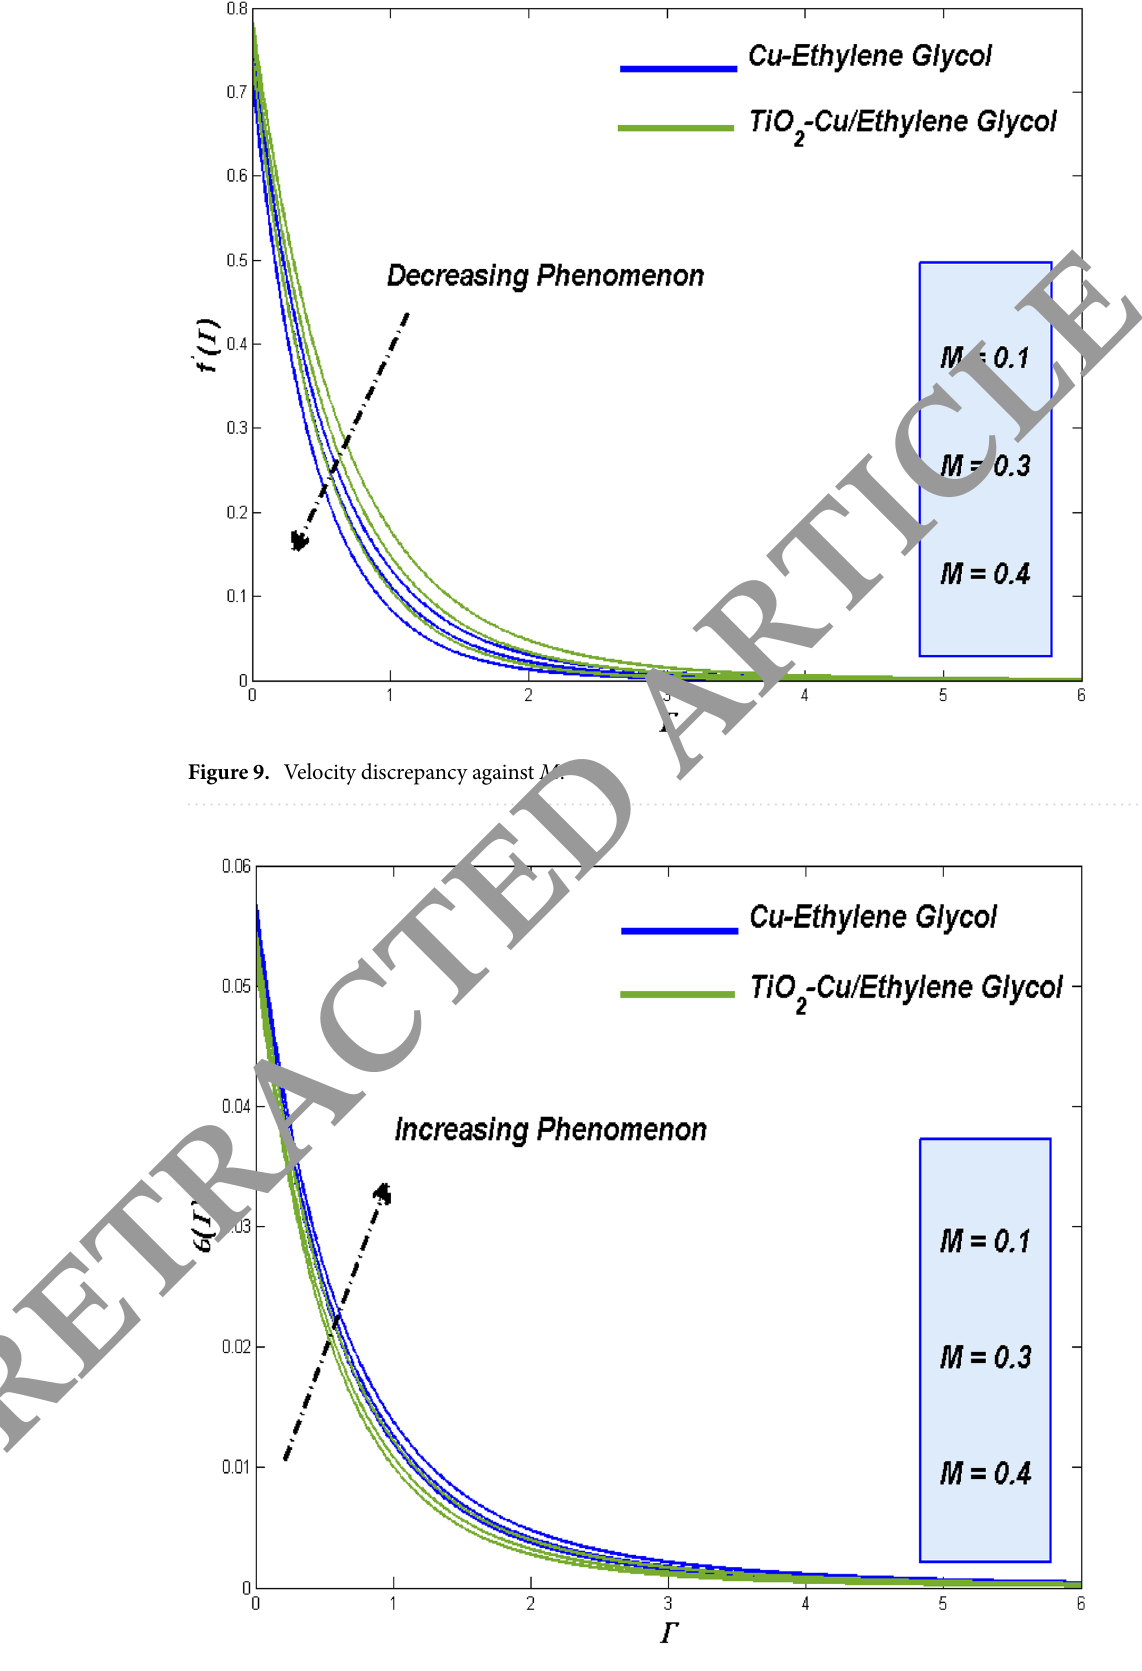
Figure 10. Temperature discrepancy against M